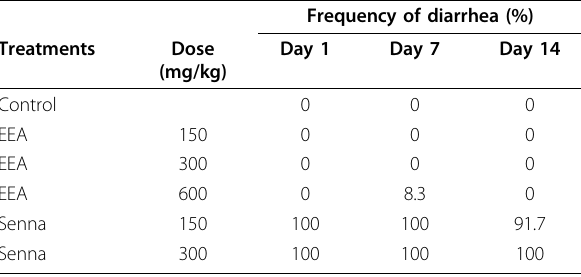
Table 4 Effects of EEA and senna on diarrhea frequency Frequency of diarrhea (%) Treatments Dose Day (mg/kg)